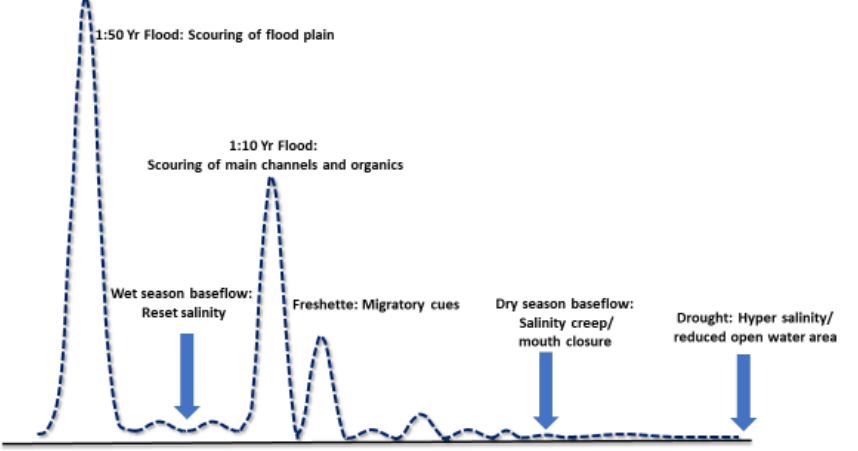
Figure 2. Conceptualization of various flow events, their frequency and functional significance that should be considered in the development of environmental flow assessments.